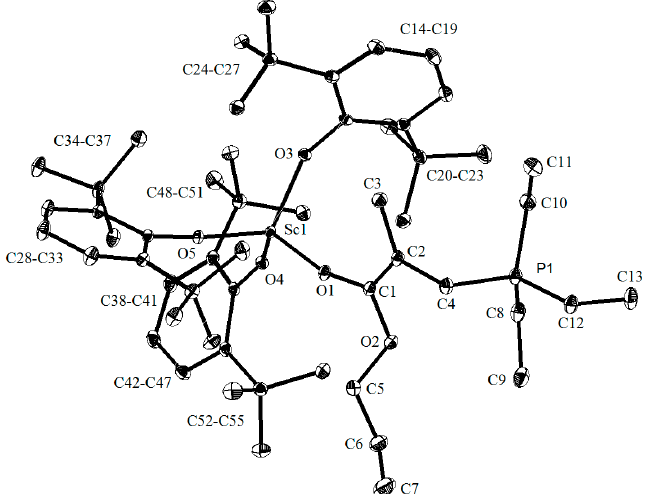
Figure 1. Molecular structure of the AMA addition product 5 . Hydrogen atoms are omitted for clarity, ellipsoids are drawn at 30% probability. Selected bond lengths (Å) and angles( o ): Sc1-O1 1.9671(11);